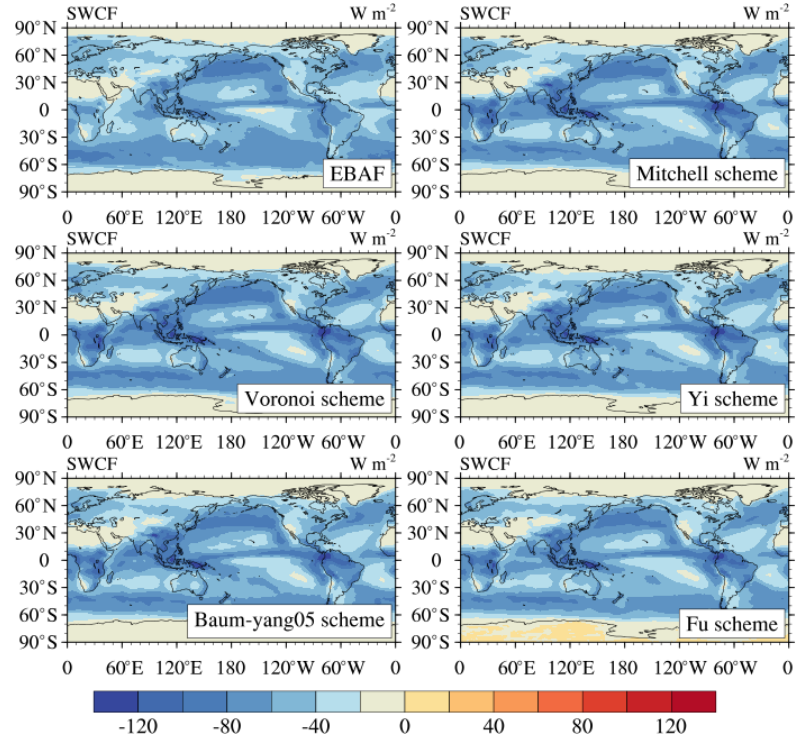
Figure 7. The 10-year globally averaged CIESM-based TOA SWCF simulations for the Voronoi, Mitchell, Fu, Baum-yang05 and Yi schemes and corresponding CERES EBAF products during 2001–2010.